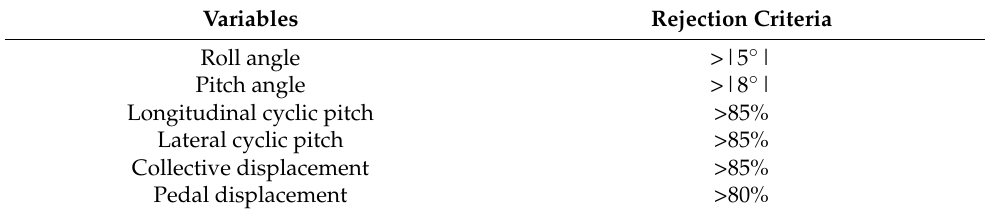
Table 4. Rejection criteria for helicopter landing on the ship flight